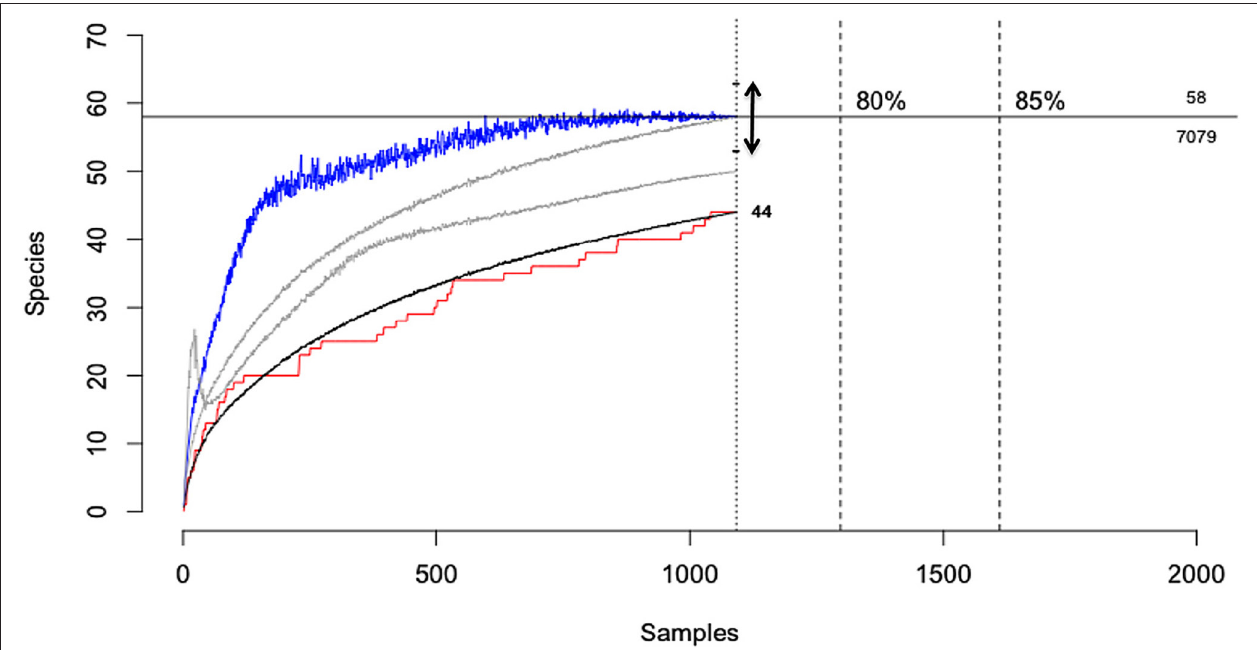
figURe 5 | Viral discovery curves for pathogens of the Indian Flying Fox ( Pteropus giganteus ) using PCR estimated from observed detections using three statistical models. The horizontal line shows the total estimated diversity (58 viruses) corrected for detectability and the effort required to discover 100% of the estimated diversity (7,079 samples). Black line, the rarefaction curve; red line, accumulation of novel viruses over samples tested; blue line, Chao2 estimator with arrow = 95% CI; gray lines, ICE and Jackknife estimators; [Adapted from ( 9 ), under creative commons